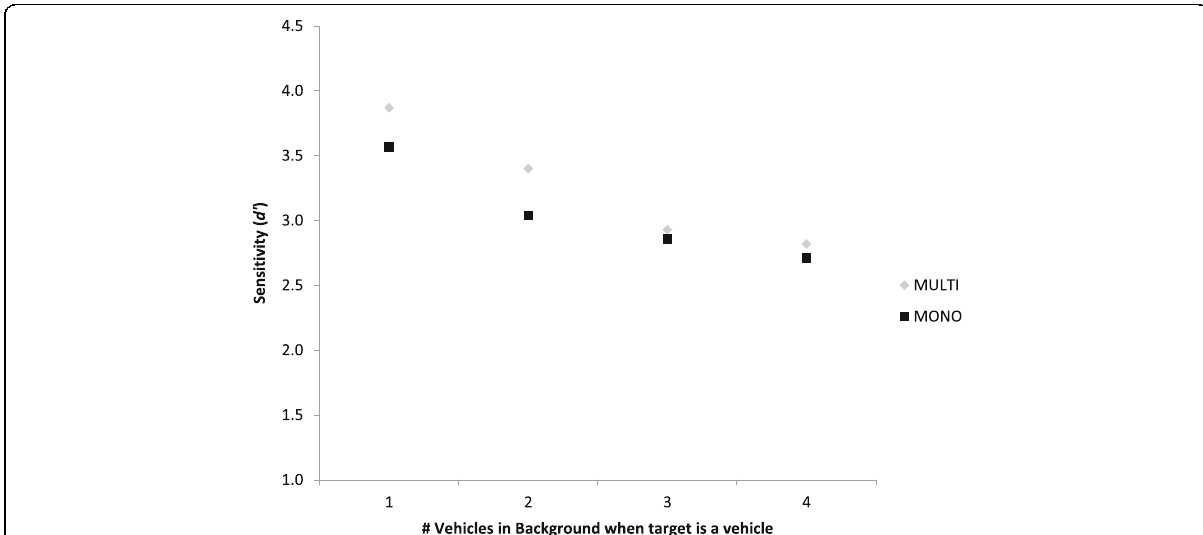
Fig. 5 Sensitivity in the change discrimination task as a function of auditory scene similarity. When the data were re-analyzed based on vehicle category membership, a significant reduction in sensitivity was observed as category-level similarity